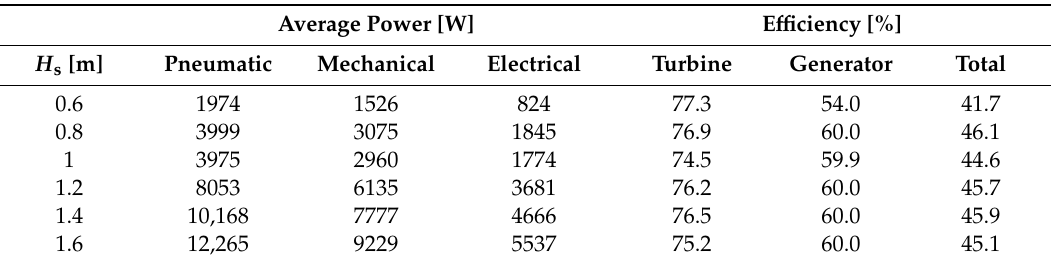
Table 5. Powers and e ffi ciencies obtained considering an Impulse turbine, with constant speed control (PI